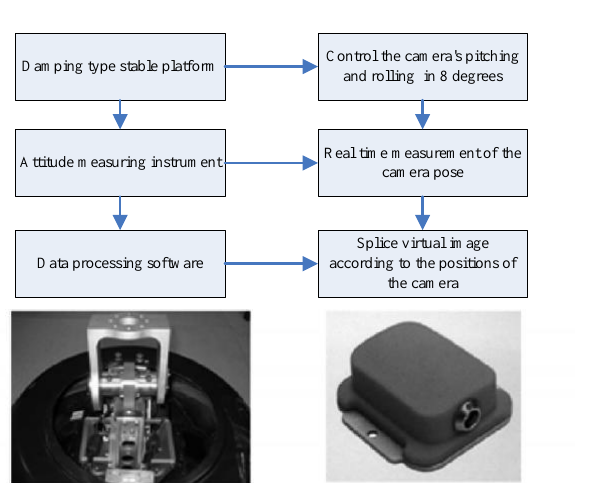
Figure 12. The structure of the stability